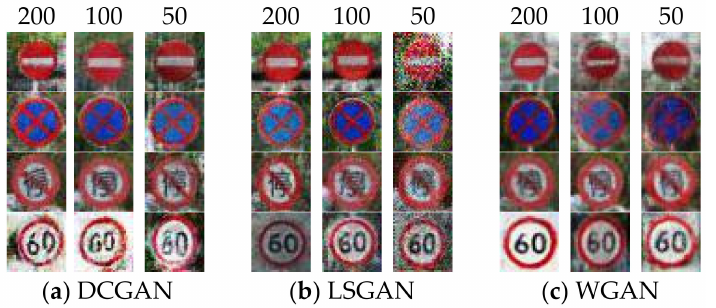
Figure 5. Synthetic traffic sign images of all classes with epoch 2000 and size 32 × 32 generated by